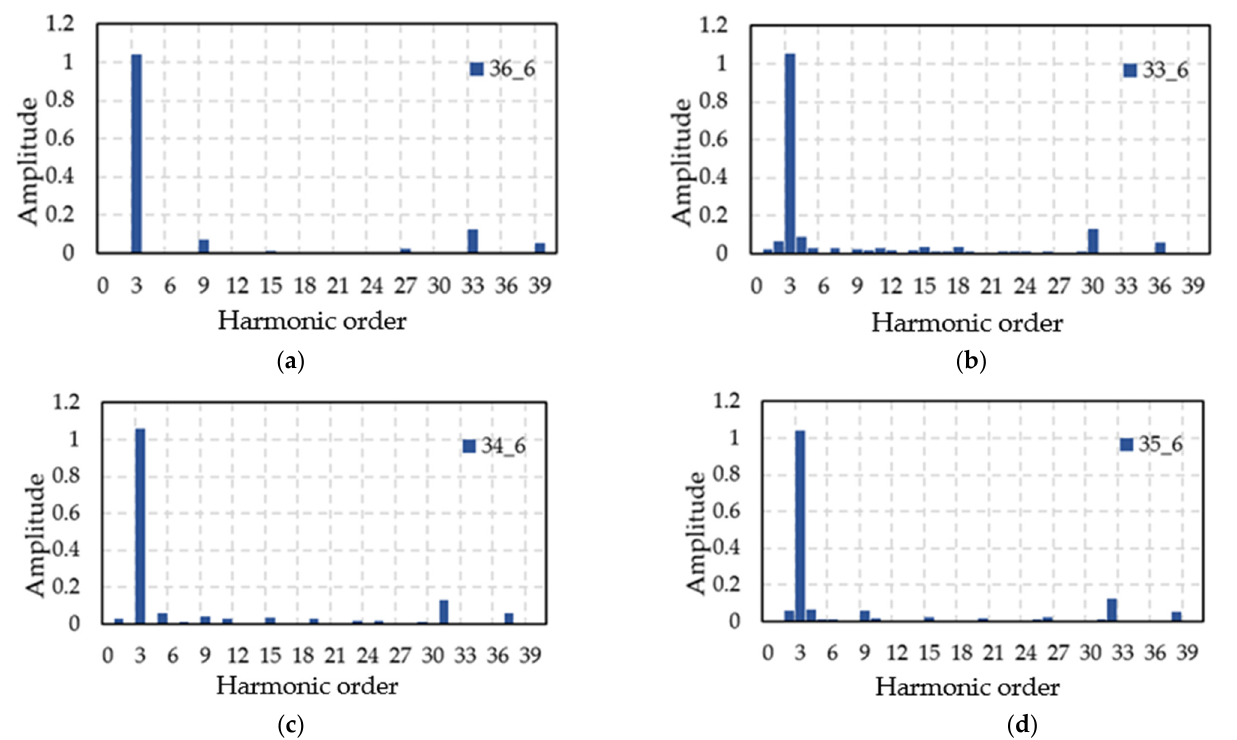
Figure 6. Air − gap flux density harmonics of four motors without flux barrier: ( a ) M 1 : 36 − slot and 6 − pole; ( b ) M 2 : 33 − slot and 6 − pole; ( c ) M 3 : 34 − slot and 6 − pole; ( d ) M 4 : 35 − slot and 6 − pole.